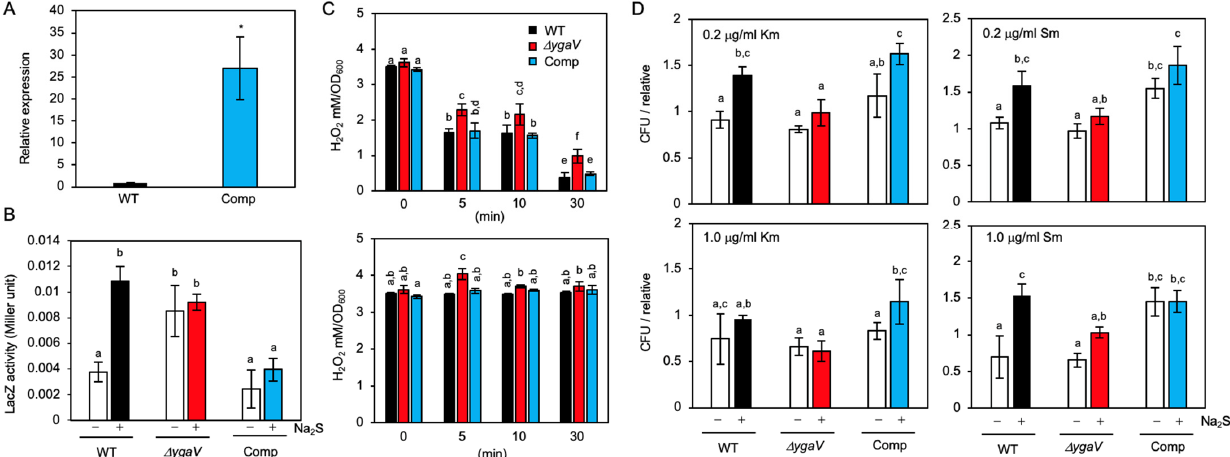
Figure 8. Phenotypes of the complementing strain of the ygaV mutant (Comp), which harbors the multicopy plasmid encoding ygaV gene: ( A ) Relative mRNA levels of ygaV in WT and the ygaV complementing strain as determined by quantitative real-time PCR analysis. The WT levels were set to 1.0. The gyrA gene was used as an internal standard. The values are means ± SD of three biological replicates. * p < 0.05, t test; ( B ) Promoter activities of the ygaVP operon. LacZ ( β -galactosidase) activity measurement with the ygaV-lacZ fusion in WT, ygaV mutant and the complementing strain. Cells grown at mid-log phase (OD 600 = ~0.3) were treated or untreated with 0.2 mM Na 2 S (final concentration) and harvested at late-log phase (OD 600 = 0.8~0.9). The values are means ± SD of three biological replicates; ( C ) H 2 O 2 levels in WT, ygaV mutant and the complementing strain. Cells grown at mid-log phase (OD 600 = 0.5–0.6) were treated with 5.0 µ g mL − 1 kanamycin (Km) (upper) or streptomycin (Sm) (bottom) (final concentration) for 5, 10 and 30 min, and then harvested. The values are means ± SD of three biological replicates; ( D ) Mean colony-forming-unit (CFU) values of WT, ygaV mutant and the complementing strain exposed to 0.2 µ g mL − 1 or 1.0 µ g mL − 1 Km or Sm (final concentration) for 30 min in the presence or absence of 0.2 mM Na 2 S (final concentration). One of the CFU values of WT at 0.2 µ g mL − 1 Km or Sm was set as 1. Different letters (a, b, c, d, e and f) indicate significant differences between groups ( p < 0.05; Tukey’s